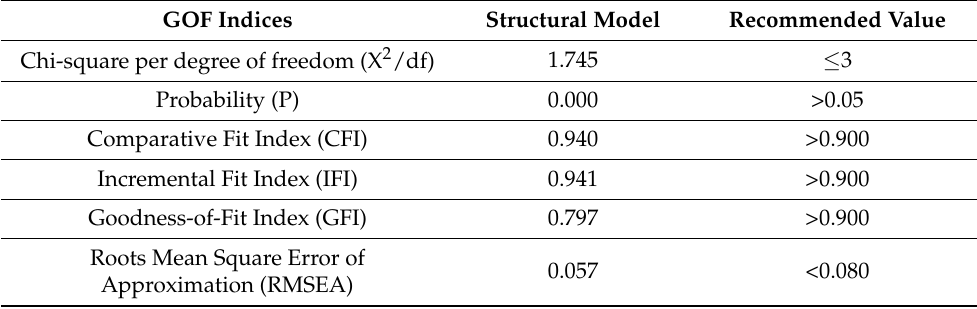
Table 4. Goodness-of-Fit for structural